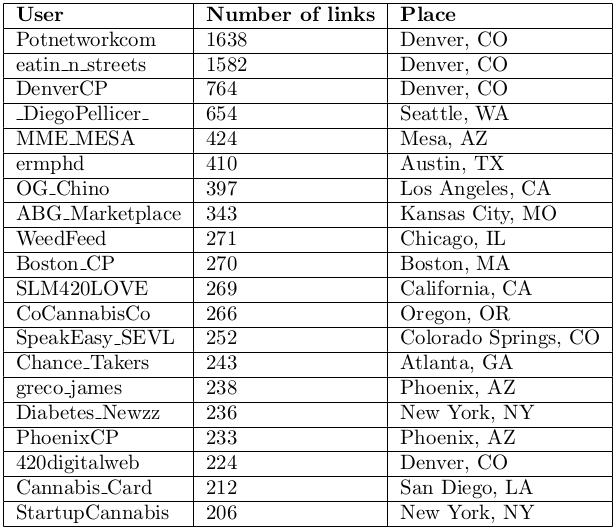
Table from the paper: Evaluating Marijuana-Related Tweets On Twitter
Table text:
User
Numberoflinks
Place
Potnetworkcom
1638
Denver,CO
eatinnstreets
1582
Denver,CO
DenverCP
764
Denver,CO
DiegoPellicer
654
Seattle,WA
MMEMESA
424
Mesa,AZ
ermphd
410
Austin,TX
OGChino
397
LosAngeles,CA
ABGMarketplace
343
KansasCity,MO
WeedFeed
271
Chicago,IL
BostonCP
270
Boston,MA
SLM420LOVE
269
California,CA
CoCannabisCo
266
Oregon,OR
SpeakEasySEVL
252
ColoradoSprings,CO
ChanceTakers
243
Atlanta,GA
grecojames
238
Phoenix,AZ
DiabetesNewzz
236
NewYork,NY
PhoenixCP
233
Phoenix,AZ
420digitalweb
224
Denver,CO
CannabisCard
212
SanDiego,LA
StartupCannabis
206
NewYork,NY